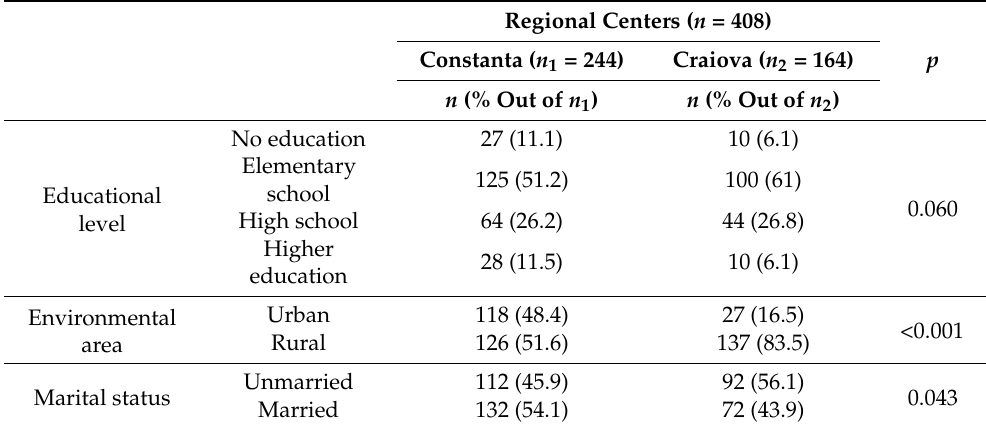
Table 2. Distribution ofHIV-positive pregnant women in both Constanta and Craiova RCs according to educational level, environmental area, and marital